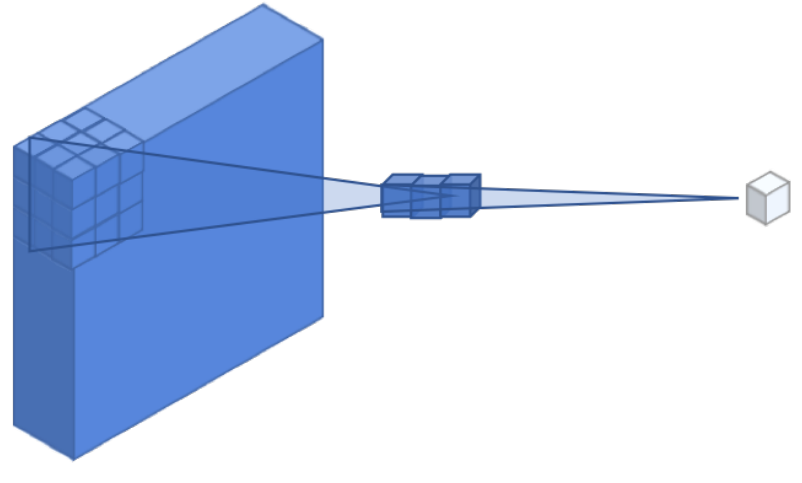
Figure 4. Depthwise separable